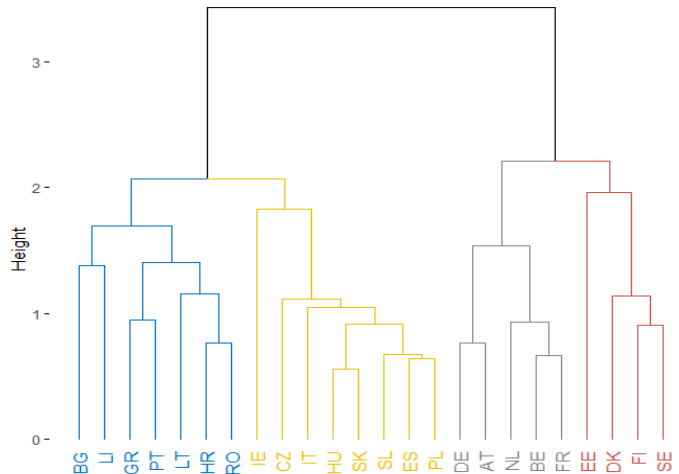
Figure 5. Cluster dendrogram for a holistic approach. Source: Authors’ study based on [75].